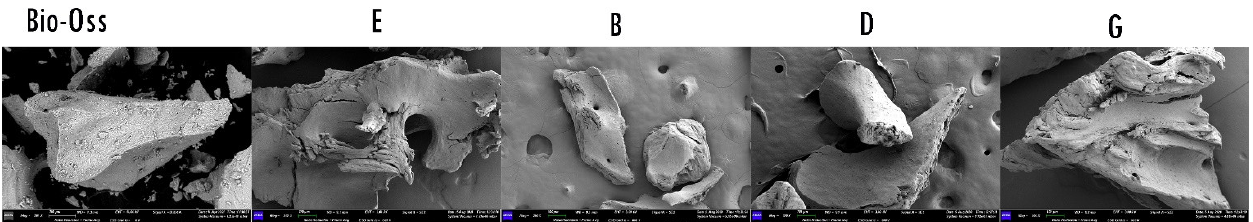
Figure 6. Scanning electron microscope (SEM) of bone grafts groups B, D, G, E, and Bio-Oss (BIOS). According to the manufacturing instructions, the bone grafts groups B and D are mainly cortical, and the bone grafts group G appears to be more cancellous; magnification 200×.